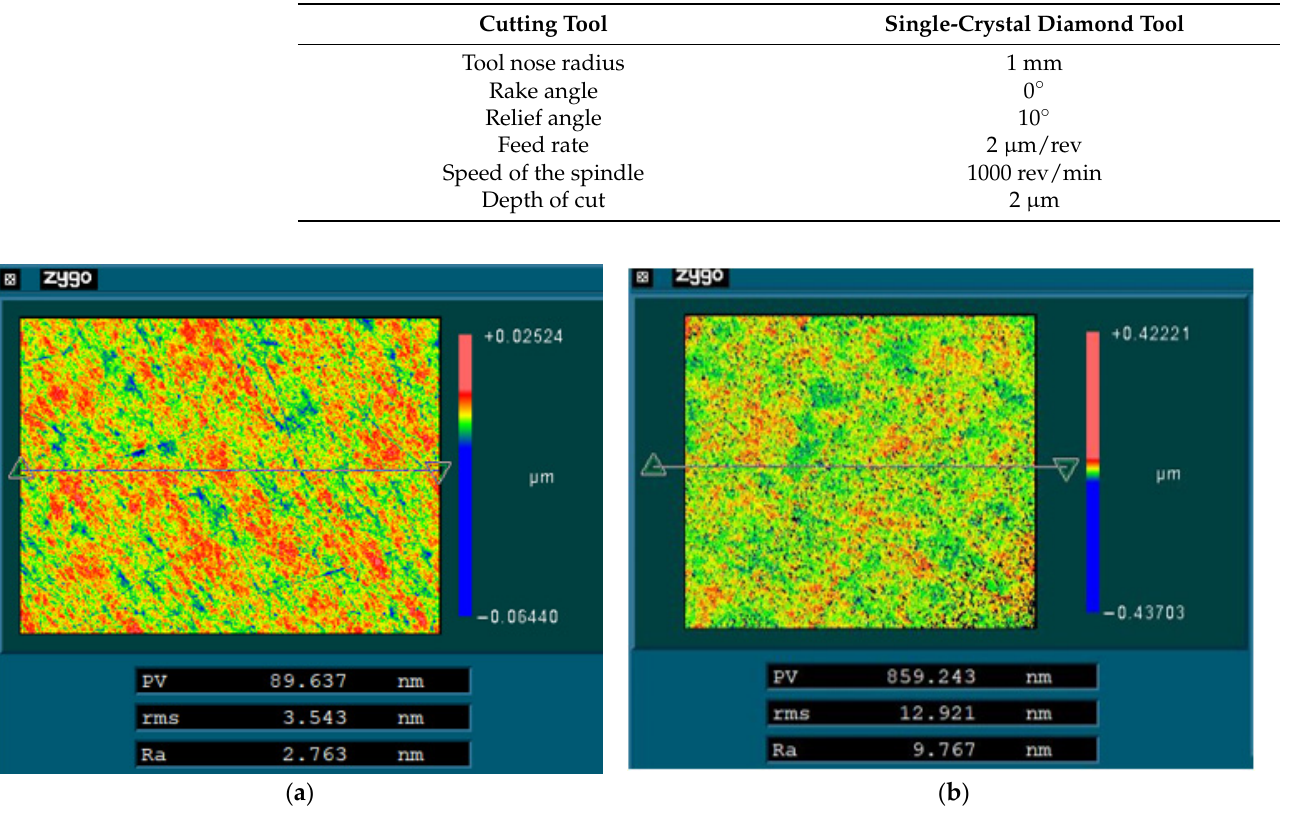
Figure 13. The roughness of SPDT surfaces: ( a ) with laser modification; ( b ) without laser modification.